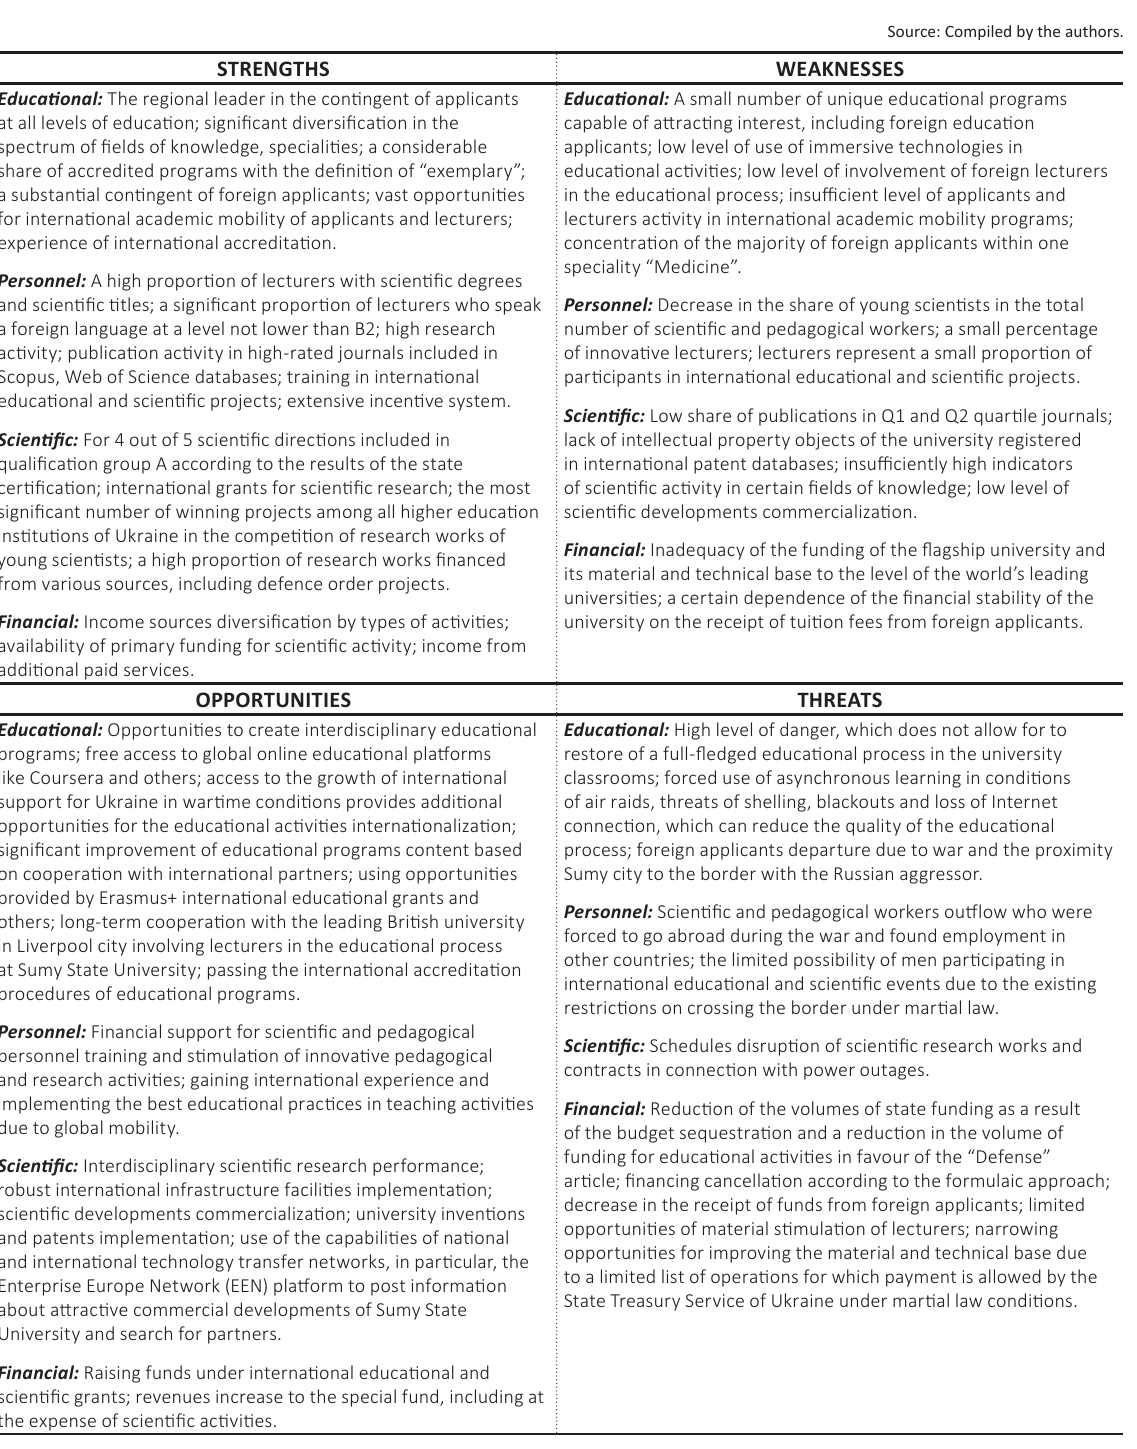
Table 1B. SWOT-analysis of Sumy State University activities in the conditions of martial